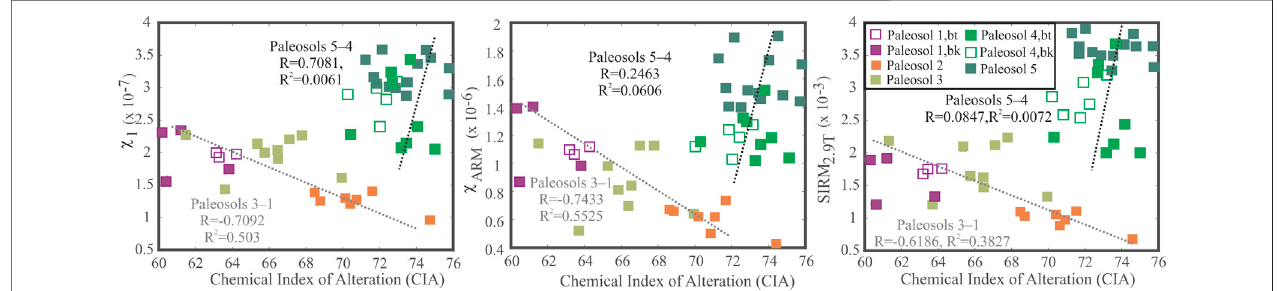
FIGURE14| Scatter-plotscomparing χ 1, χ ARM ,andSIRM 2.9T totheChemicalIndexofAlteration(CIA)calculatedby(Stineet al.,2020).Notehoweach scatterplot results in two clusters. The cluster associated with the mixed sediments (Paleosols 3-1), shows a moderate negative correlation between rock-magnetic values and weathering intensities. This implies that the magnetically depleted values are related to the degree of weathering. The cluster associated with the Pecos-derived sediments(Paleosols5-4),showsalowcorrelationbetweenthehigh-magneticvaluesofthosepaleosolsandthecalculatedweatheringintensities.Nevertheless,it should be noted that the CIA values for Paleosols 5-4 are suspect due to high quartz content (Stine et al., 2020).